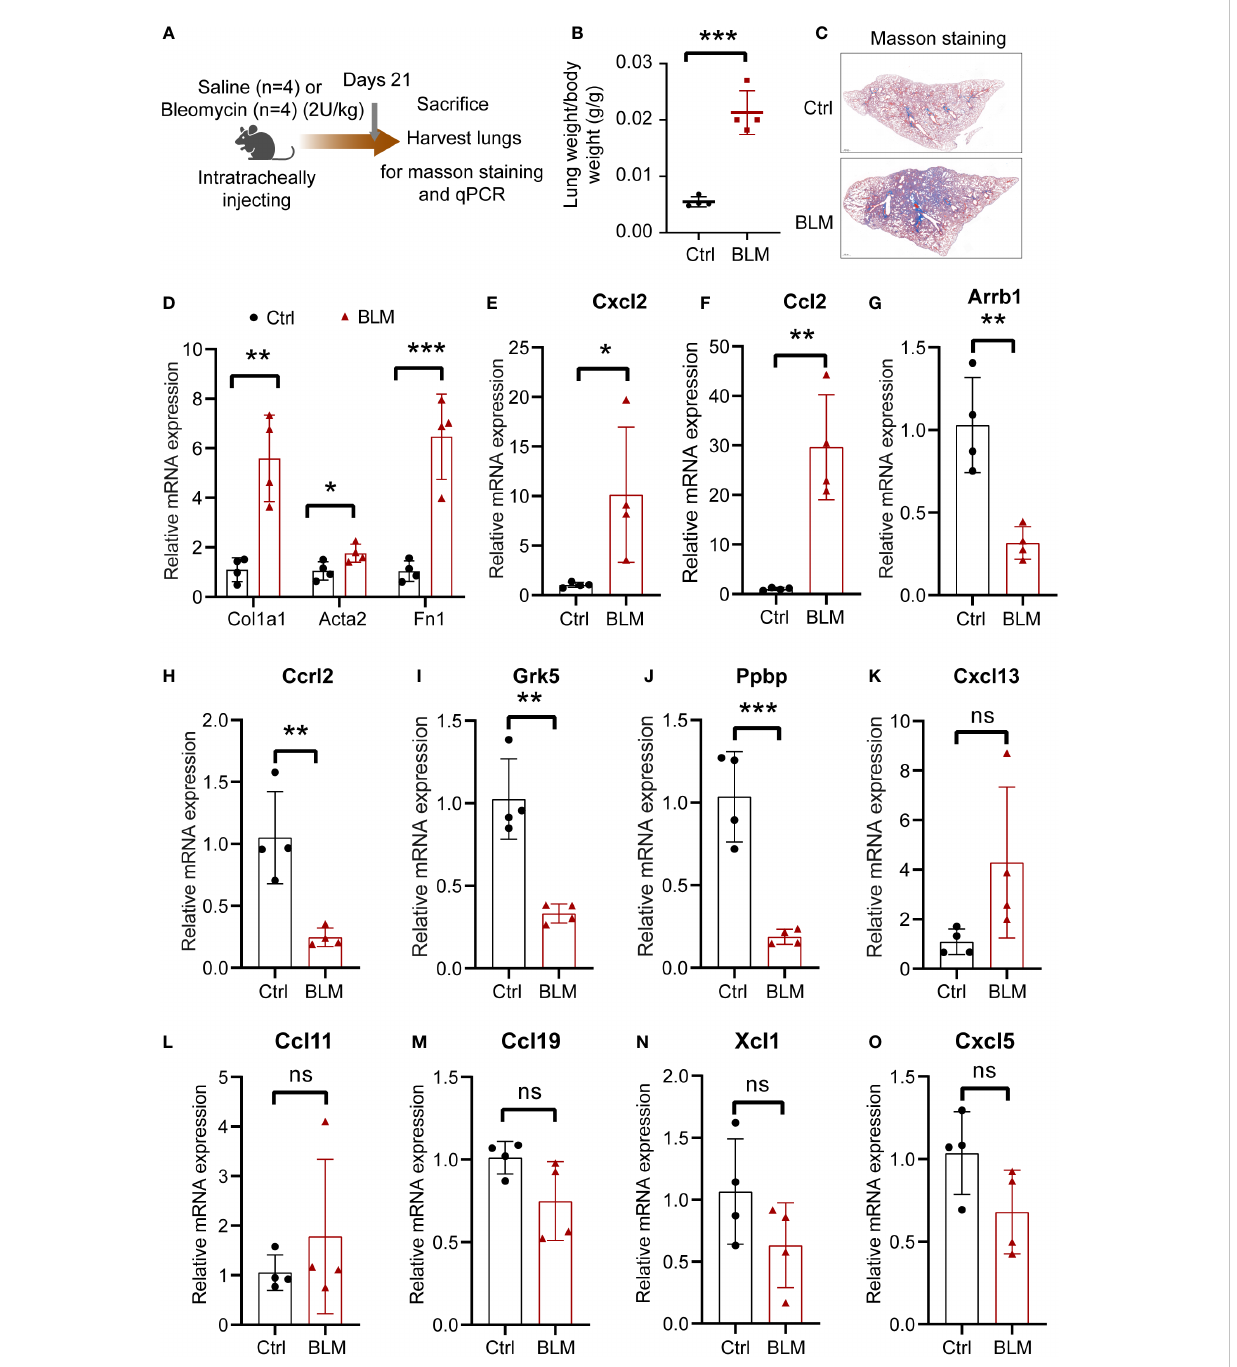
FIGURE 9 The expression of the eleven CR-DEGs in bleomycin-induced lung fi brosis. (A) Schematic diagram of bleomycin-induced lung fi brosis. (B) Lung index (lung weight/body weight). (C) Representative images of Masson ’ s trichrome staining of the lung section. (D) mRNA levels of Col1a1, Acta2, and Fn1 in lung tissue. (E-O) mRNA levels of Cxcl2 (E) , Ccl2 (F) , Arrb1 (G) , Ccrl2 (H) , Grk5 (I) , Ppbp (J) , Cxcl13 (K) , Ccl11 (L) , Ccl19 (M) , Xcl1 (N) , and Cxcl5 (O) in control and bleomycin group.. Values were expressed as mean ± SD (n = 4), *p < 0.05, **p < 0.01, ***p < 0.001. t test was used. Ctrl, control; BLM, bleomycin; ns, not signi fi cant